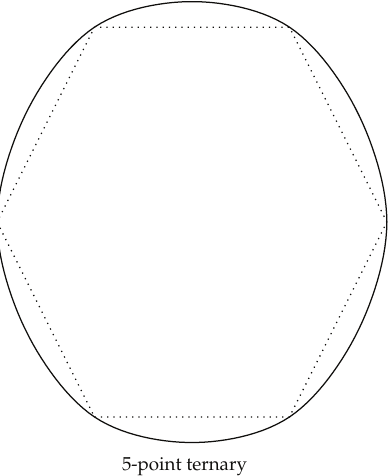
Figure 6: Limit curve after applying 5-point ternary subdivision scheme on initial convex data. Dotted line shows initial convex data and solid line indicates limit curve after two